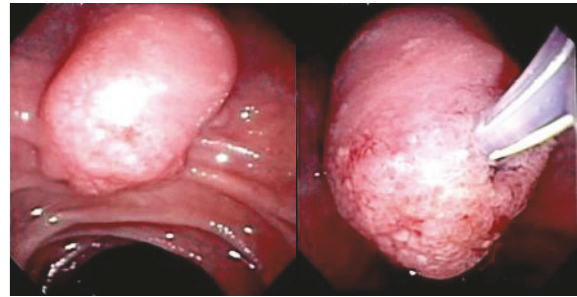
Figure 2: Endoscopic (ERCP) images reveal a 2cm ampullary mass.